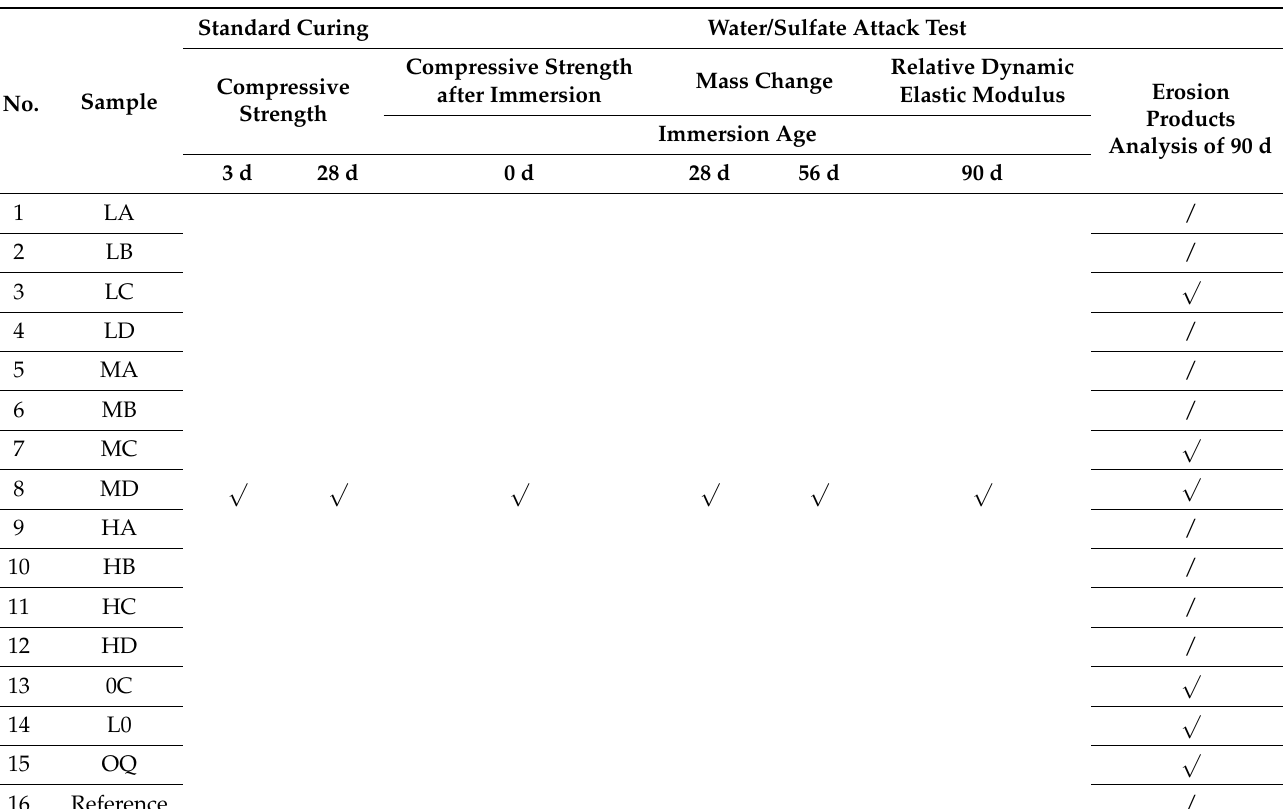
Table 4. Experimental